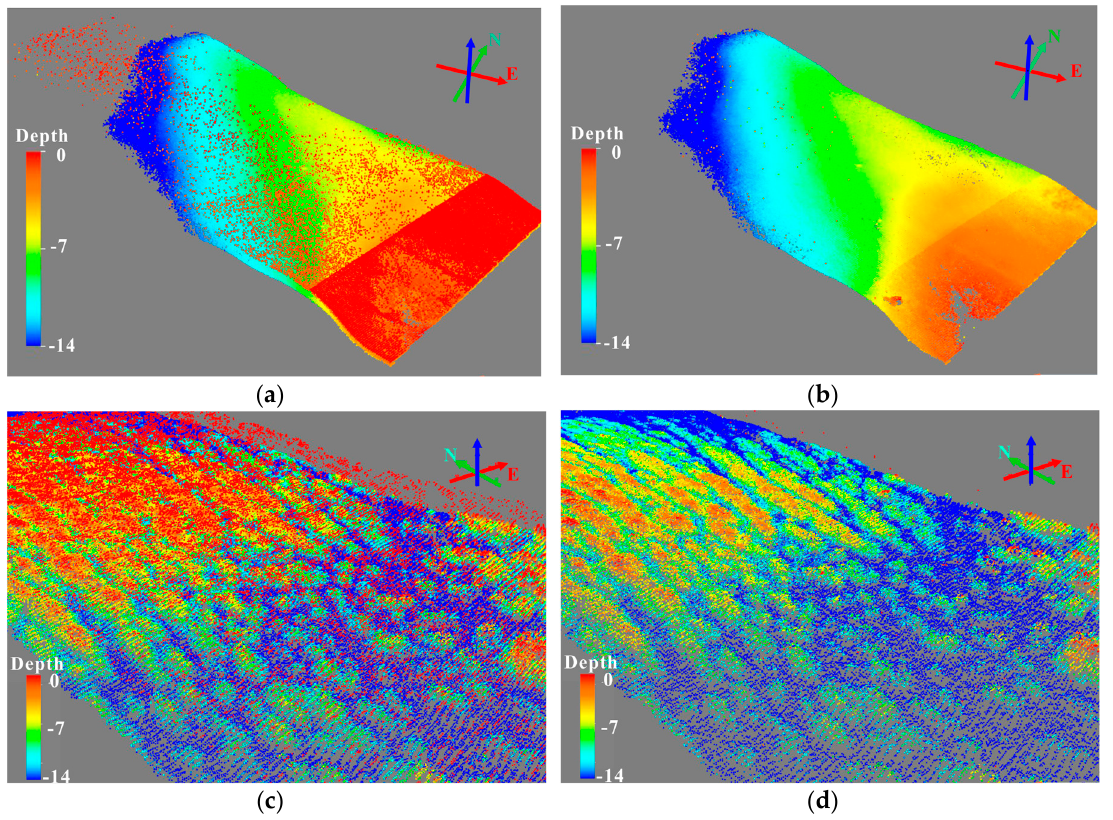
Figure 13. Comparison of underwater terrain resolution. (( a , c ): Results of Aquarius software waveform processing; ( b , d ): Point cloud processed by the GHPD method).